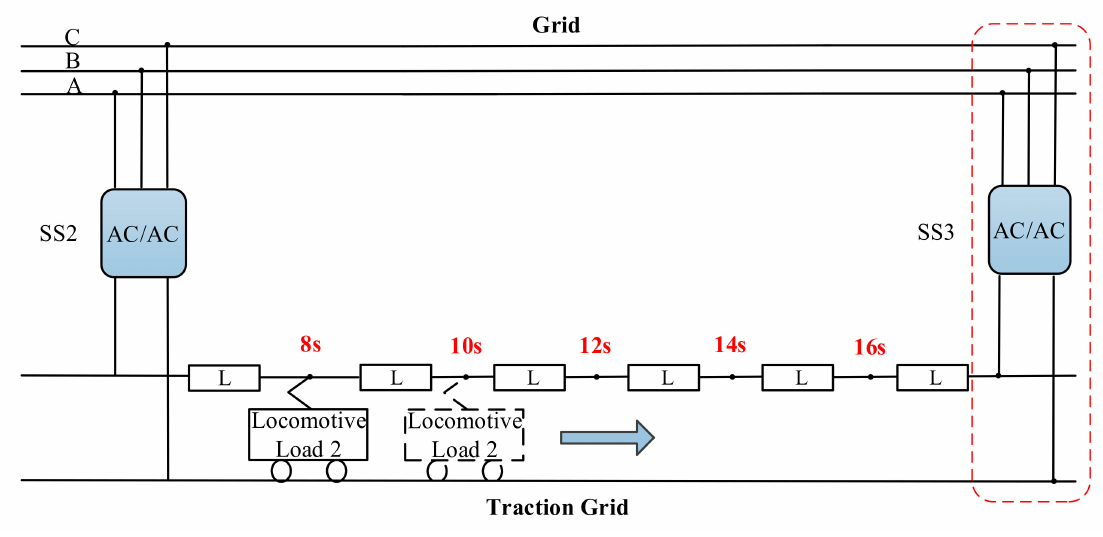
Figure 12. The system structure when the load is moving.